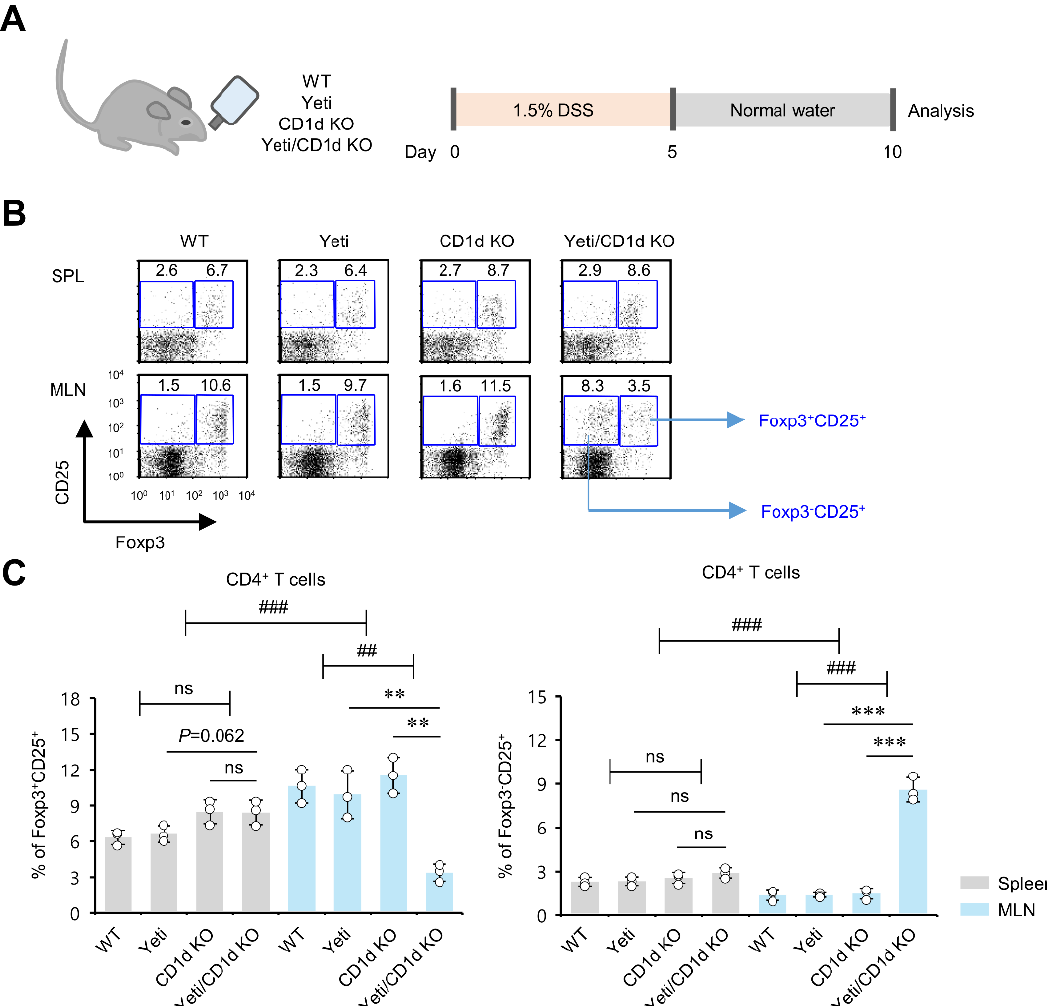
Figure 1. Dysregulated IFNγ expression in the absence of iNKT cells causes alterations in Foxp3 expression by CD25 + CD4 + T cells in the MLNs, but not the spleen during DSS-induced colitis. ( A ) Experimental outline. WT, Yeti, CD1d KO, and Yeti/CD1d KO mice were treated with 1.5% DSS as described in Materials and Methods. ( B ) On day 10, the spleen and MLNs were obtained from these mice. The percentages of Foxp3 + CD25 + and Foxp3 − CD25 + subpopulations gated on CD4 + T cells from the spleen and MLNs of each group were measured by flow cytometry. Representative data ( B ) and their summary ( C ) are shown. The mean values ± SD ( n = 3; per group in the experi ment; Student’s t -test; ** p < 0.01, *** p < 0.001) are shown. Two-way ANOVA (Yeti × iNKT) showed an interaction between these two factors ( ## p < 0.01, ### p < 0.001). Two-way ANOVA (genotype × tissue) showed